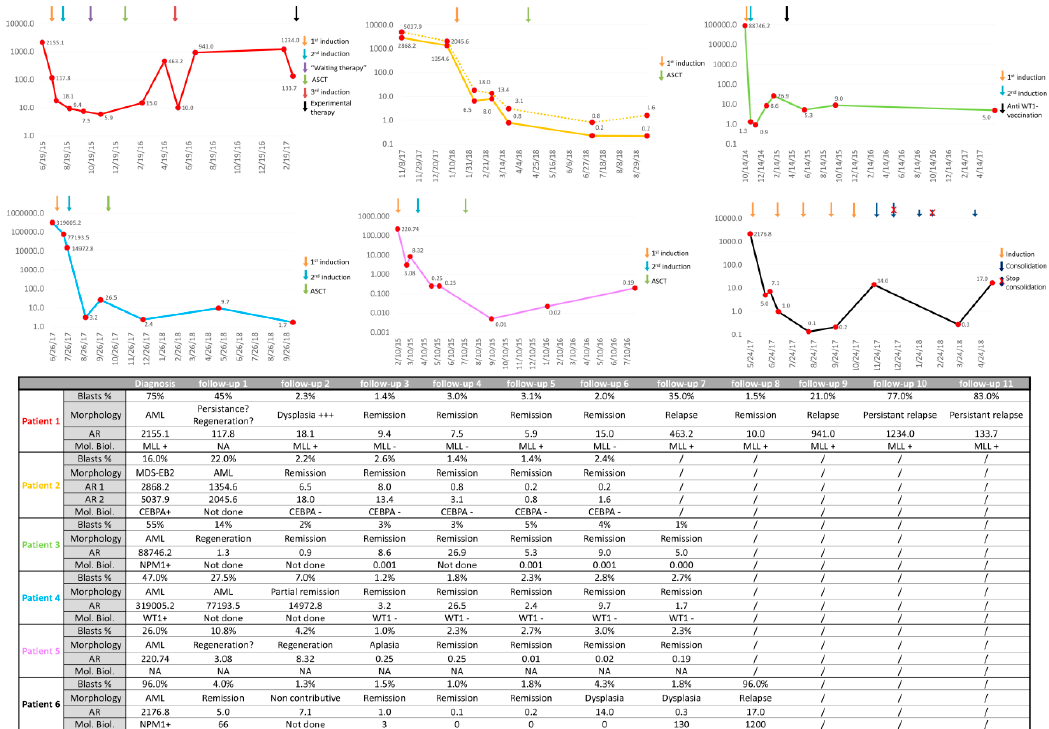
Figure 4. Comparison of the Abnormality Ratio (AR) with morphology and molecular biology results over time for six acute myeloid leukemia patients. Graphics: abscissa = time (DD / MM / YY); ordinate = AR; ASCT: allogeneic stem cell transplantation; induction: induction therapy; consolidation: consolidation therapy; Blasts%: percentage of blast cells among nucleated cells established on morphological basis on bone marrow aspirate; Morphology: bone marrow aspiration conclusion based on morphological results; Mol. Biol.: bone marrow aspirate molecular biology results (follow-up columns) based on mutations at diagnosis (diagnosis column). The presence of MLL at follow-up was evaluated by RT-PCR, with a limit of detection (LOD) of 5%. The presence of CEBPA mutation at follow-up results was evaluated by PCR, followed by Sanger sequencing, with a LOD of 10%. The presence of NPM1 at follow-up was evaluated by RT-PCR with a limit of detection of 1:10,000 cells. NPM1 results are expressed in terms of percentage ratio (NPM1 / ABL1); the presence of WT1 expression at follow-up was evaluated by RT-PCR ( + = WT1 overexpression; − = no WT1 overexpression). RT-PCR: reverse transcriptase–polymerase chain reaction; NPM1: nucleophosmin 1; MLL: partial tandem duplication of KMT2A gene; CEBPA: CCAAT enhancer binding protein alpha gene; WT1: Wilm’s tumor 1 gene; AR: Abnormality Ratio. AR1 and AR2 for patient 2 were defined because two cell clusters of at least 5 × 10 3 cells had an AR > 1000 at diagnosis (two di ff erent